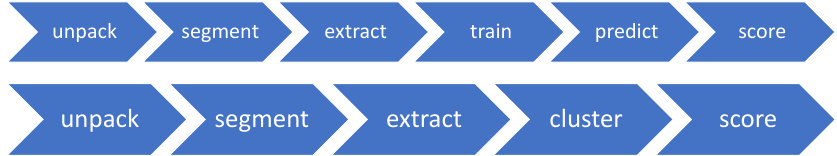
Figure 2. The Grtool pipeline. Each step represents an independent, parallelizable module. Compare the supervised (top) and unsupervised (bottom) pipelines, where the train and predict steps in the former are replaced by the clustering step in unsupervised Activity Recognition